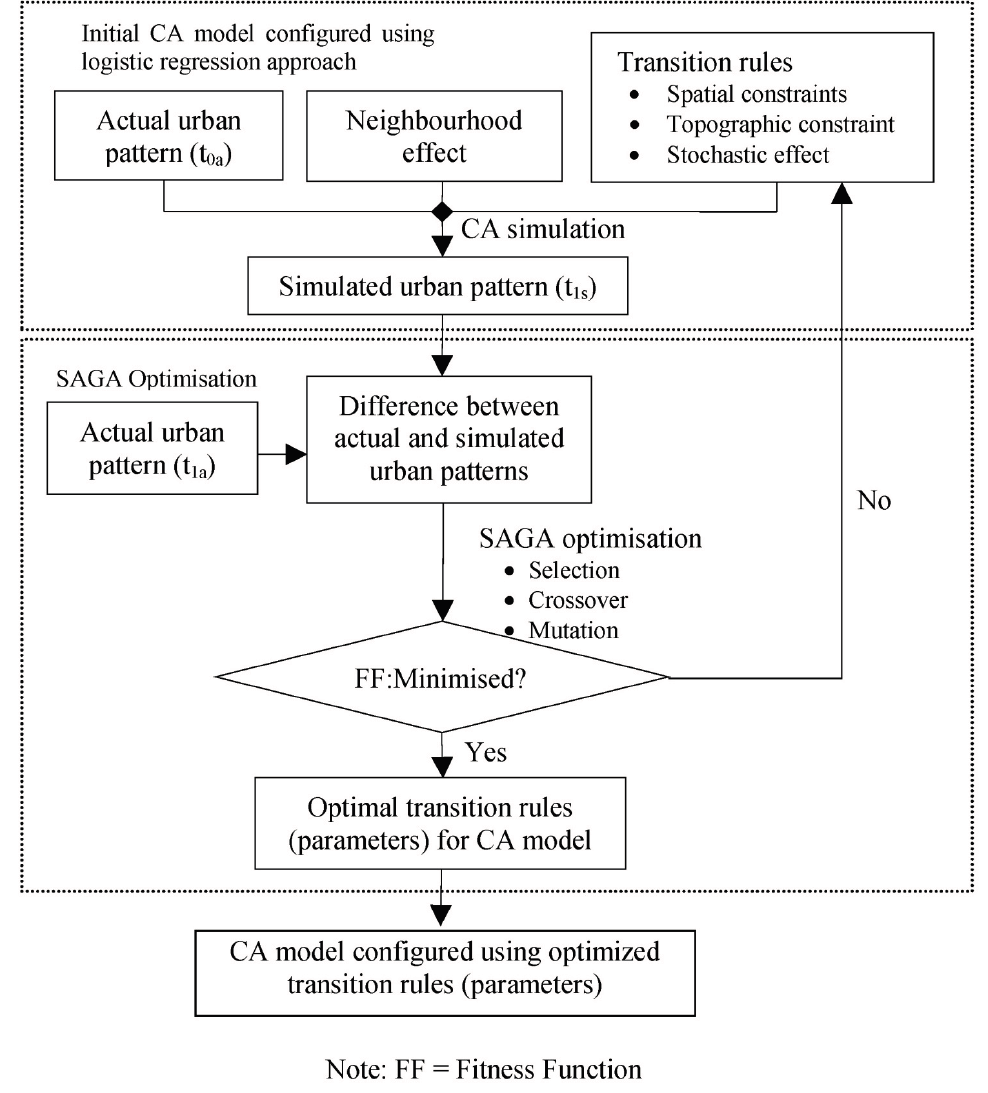
Figure 4. The SAGA process searching for the optimal CA transition